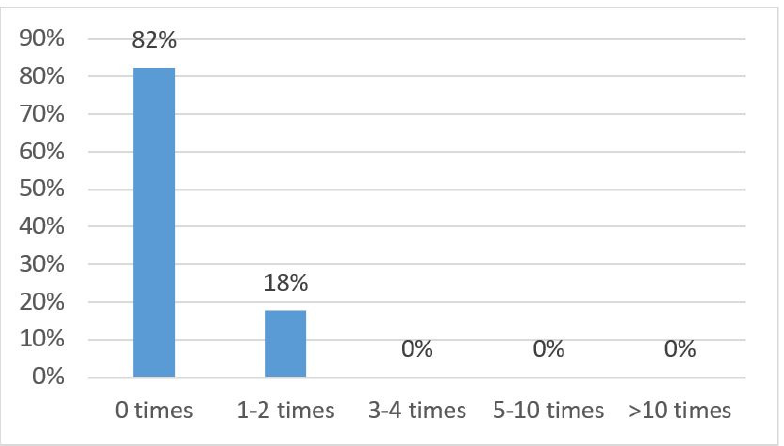
Figure 4. Frequency of use of the VHF Digital Selective Calling (DSC).